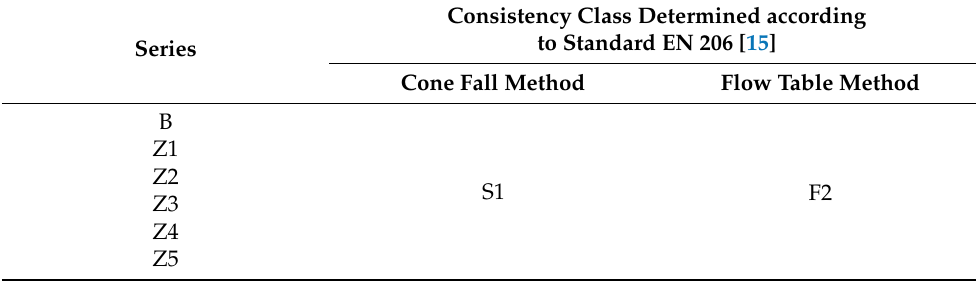
Table 3. Consistency classes of the concrete mixes.